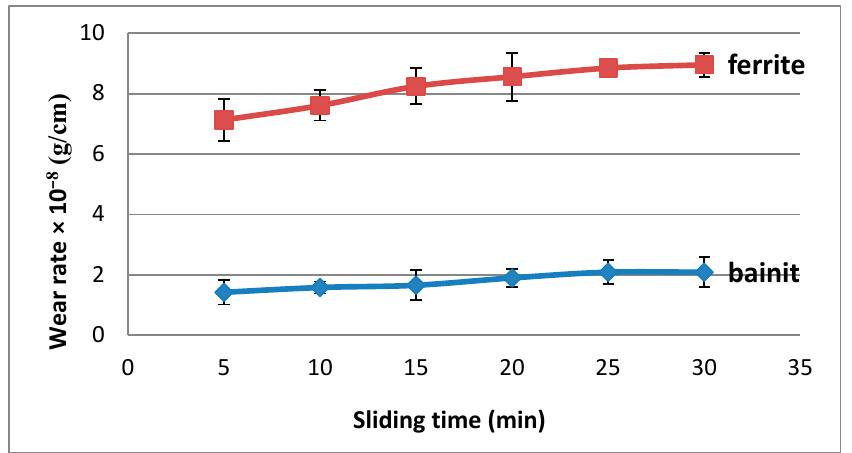
Figure 7. Effect of microstructure on the wear rate at a load of 52.015 N and sliding speed of 70 cm/sec.